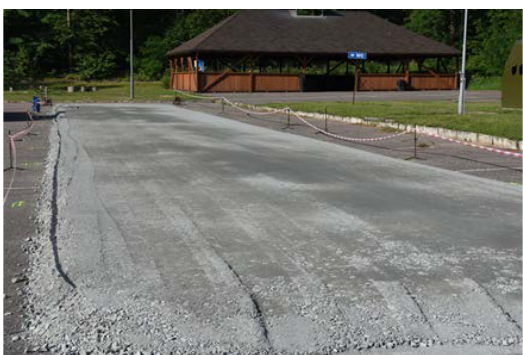
Figure 13. Parking lot area leveled out with the unbound aggregate base course.